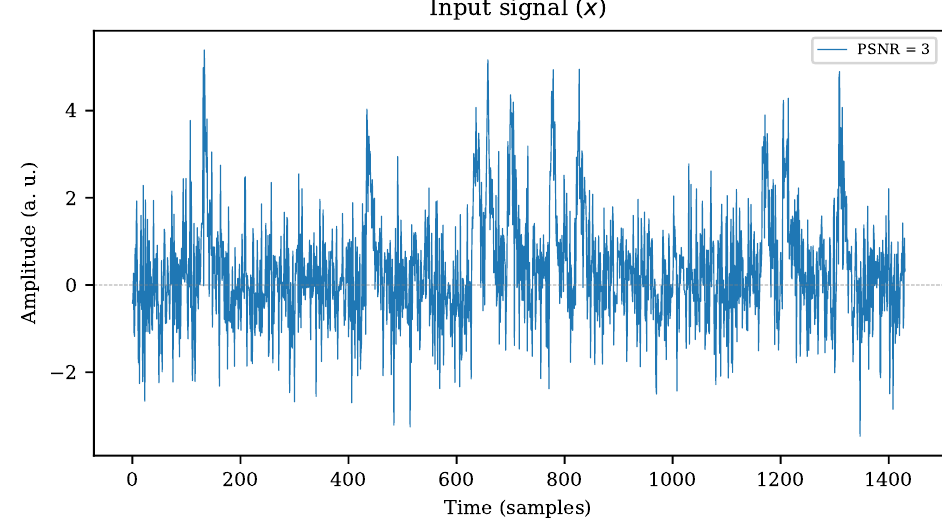
Figure 9. Synthetic stimulus signal composed by 10 individual pulses with additive white gaussian noise emulating a PSNR equal to 3.